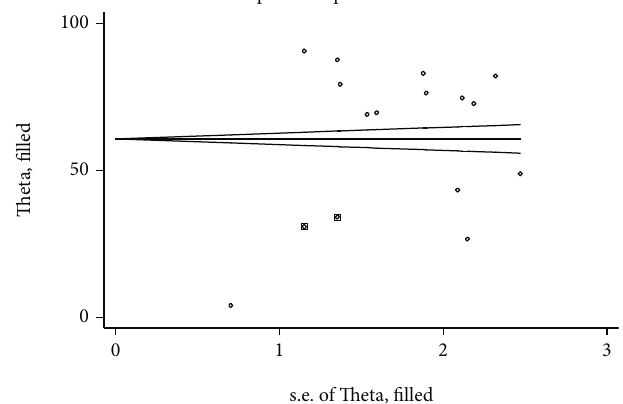
Figure 6: Filled funnel plot after adjusting for publication bias with 95% con fi dence limits.